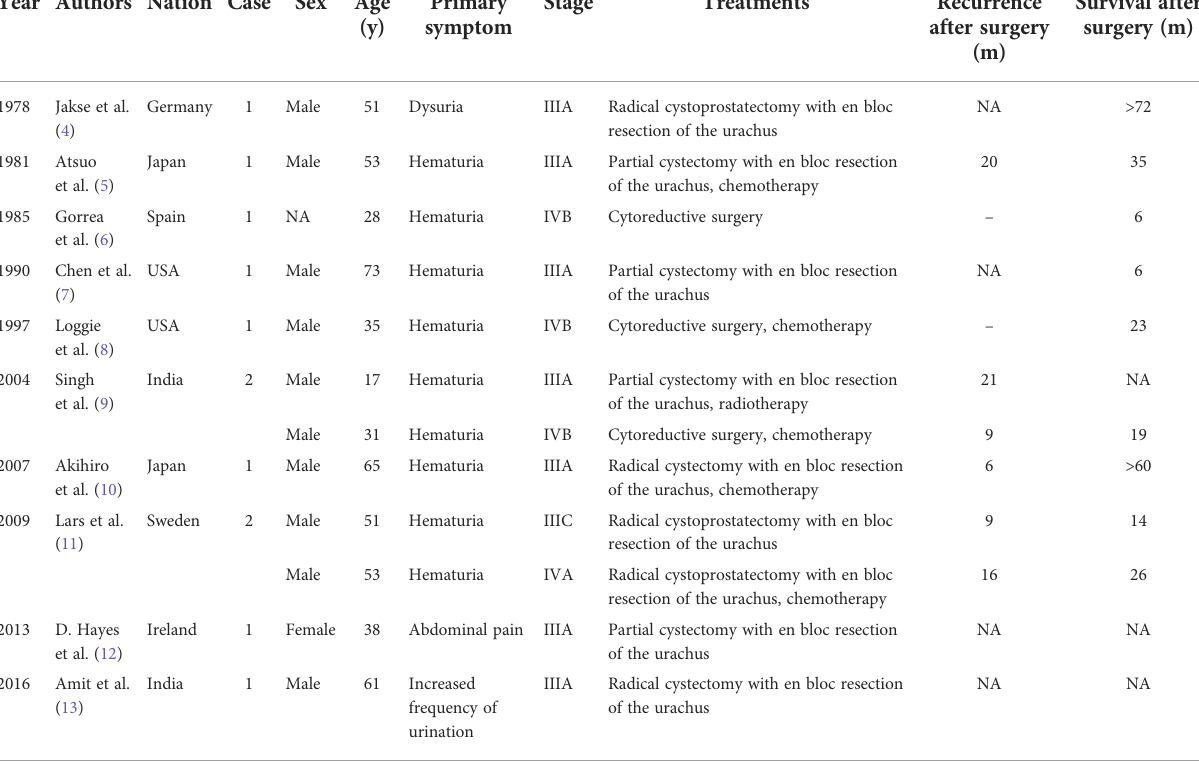
TABLE 1 Overview of previous case reports regarding primary urachal signet ring cell